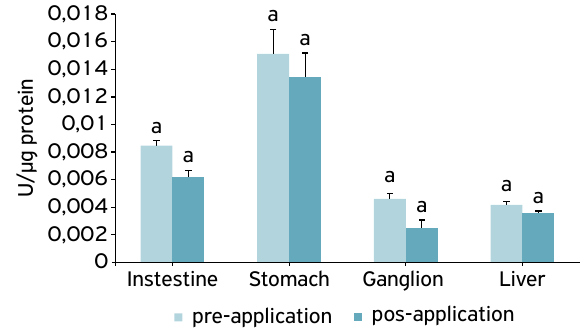
Figure 5. Evaluation of lipase activity in tissues (intestine, stomach, liver and ganglia) Achatina fulica depending on the concentration of protein in the protein extract of tissues before and after exposure to the alcoholic extract of Capsicum frutescens at the concentration of 10% (Tukey, p ≤